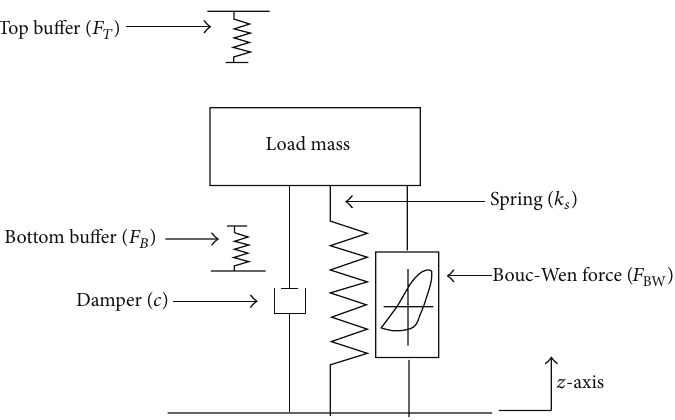
Figure 13: Schematic of the Bouc-Wen model [14].